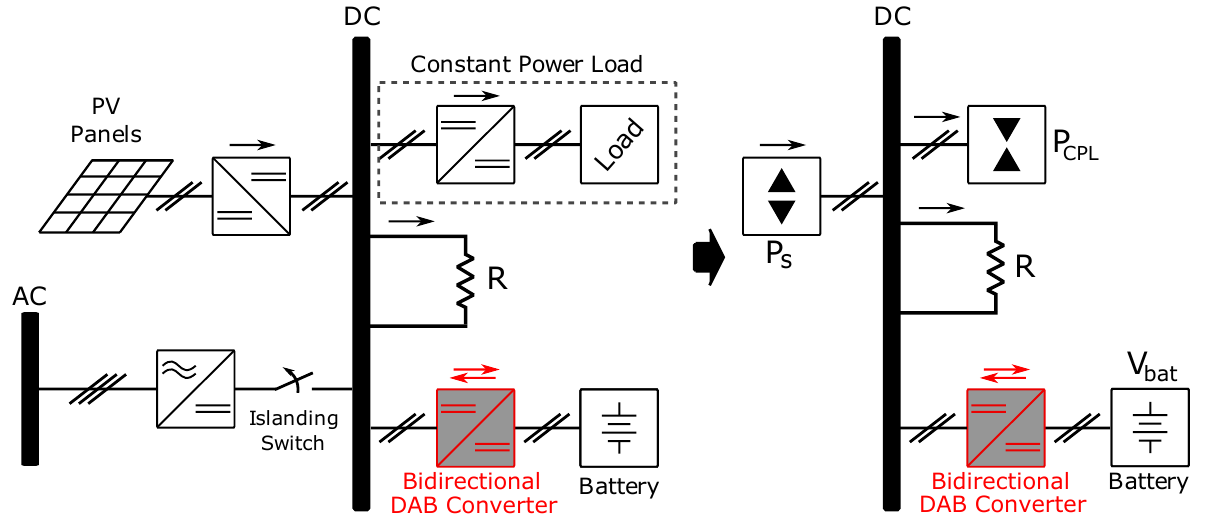
Figure 5. Microgrid equivalent (reduced)